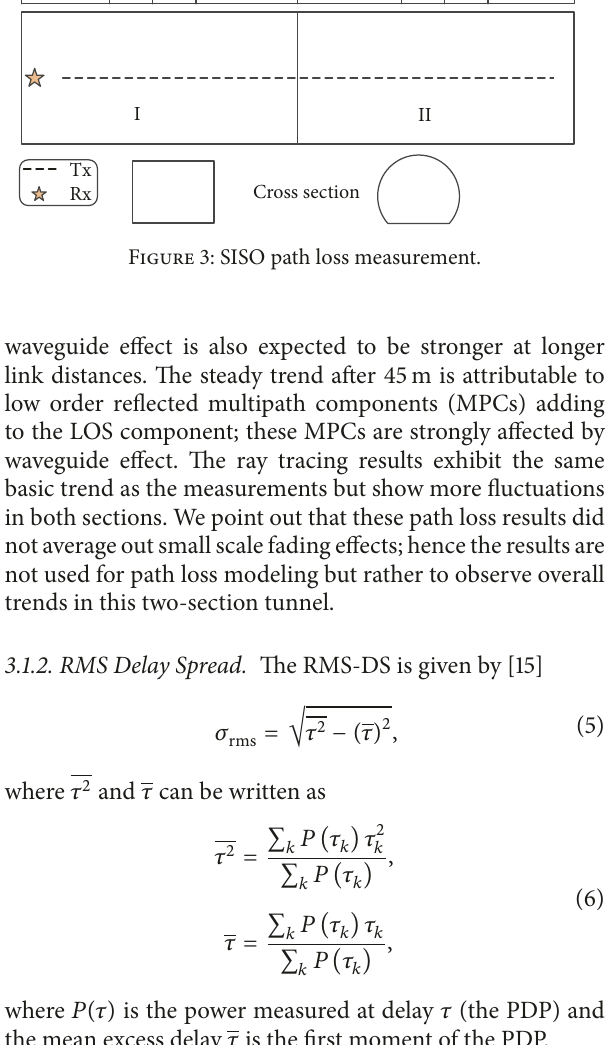
Table 1: Measurement parameters.